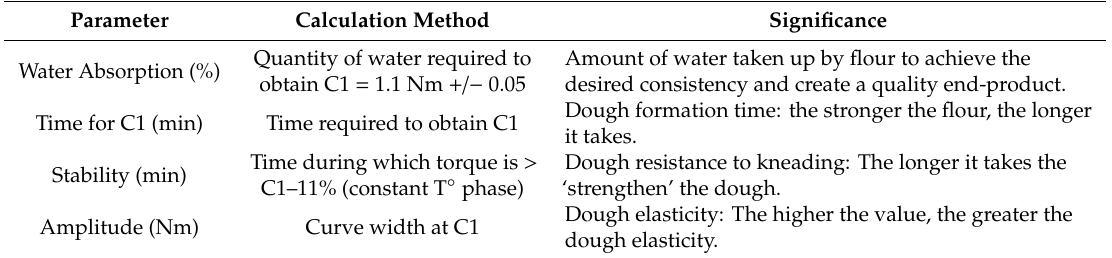
Table 2. Mixolab parameters correlation and